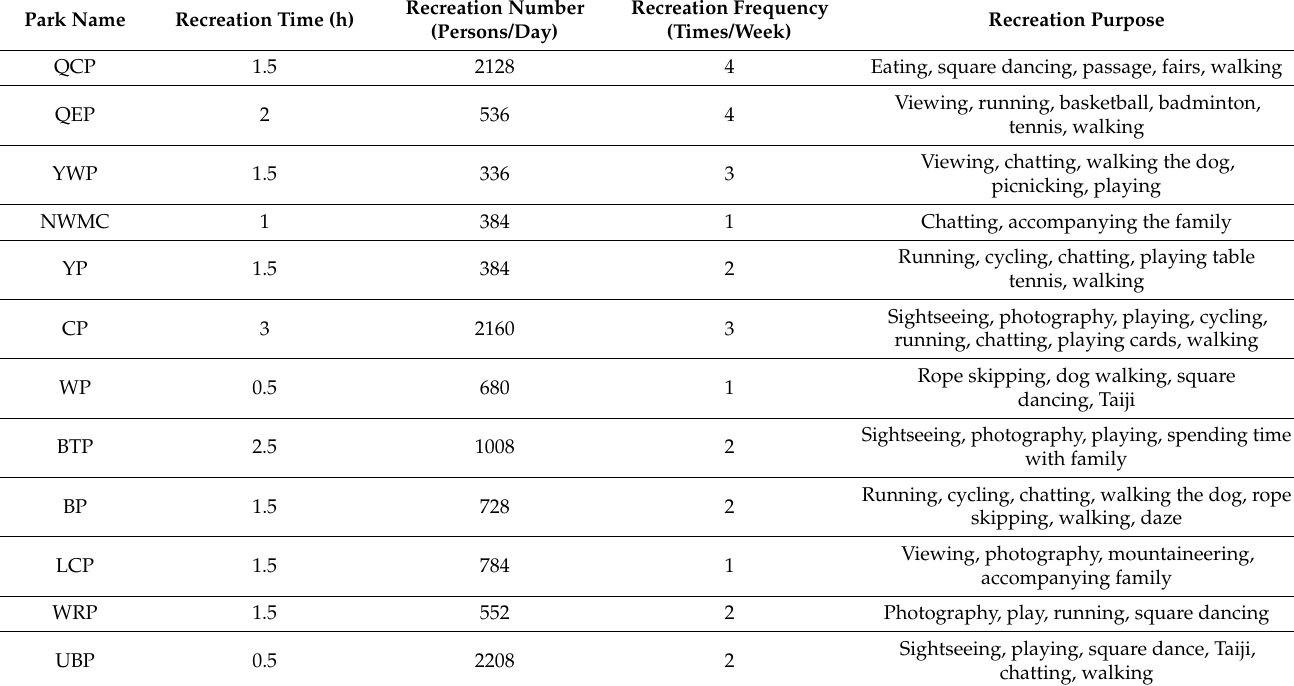
Table 8. User behavior observation record